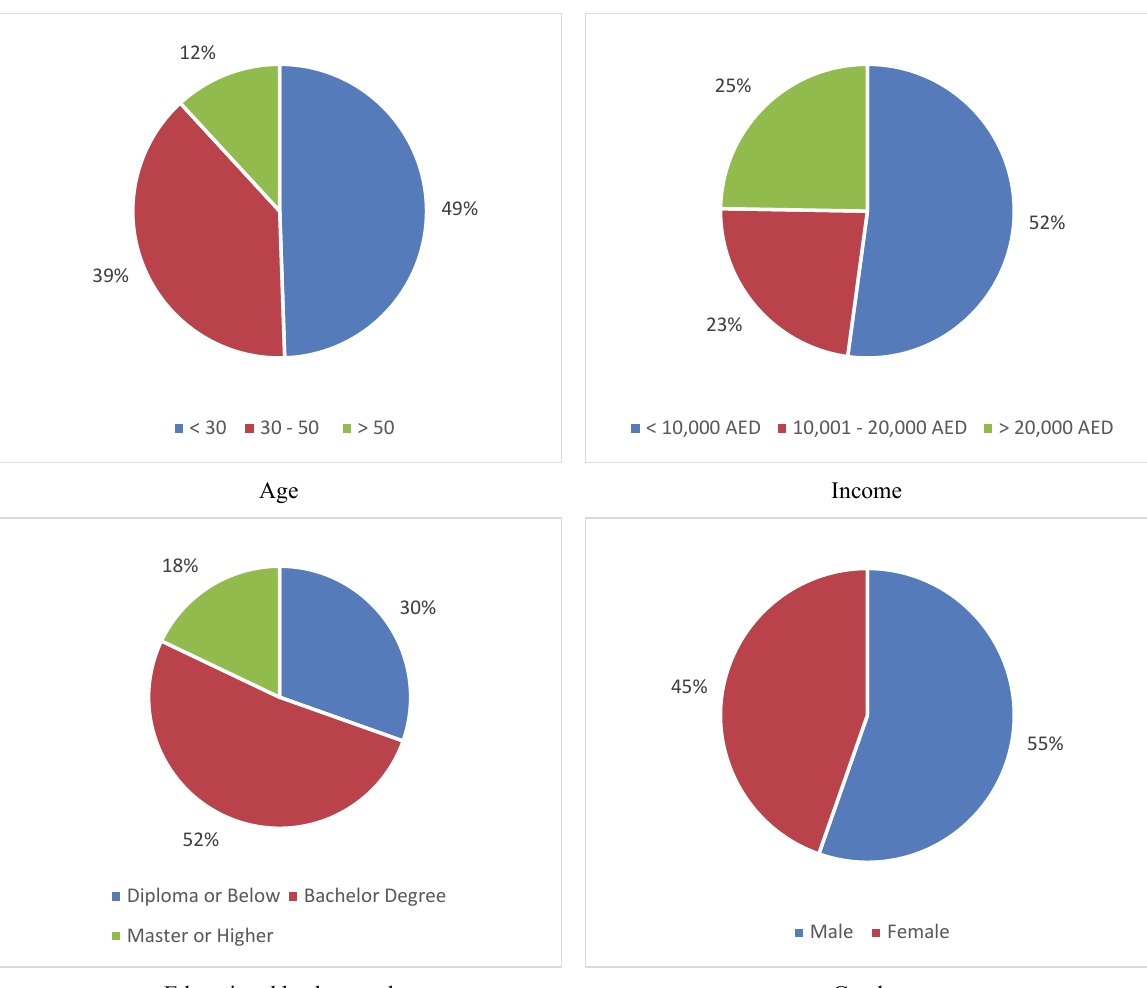
Fig. 2. Demographic Profiles of the